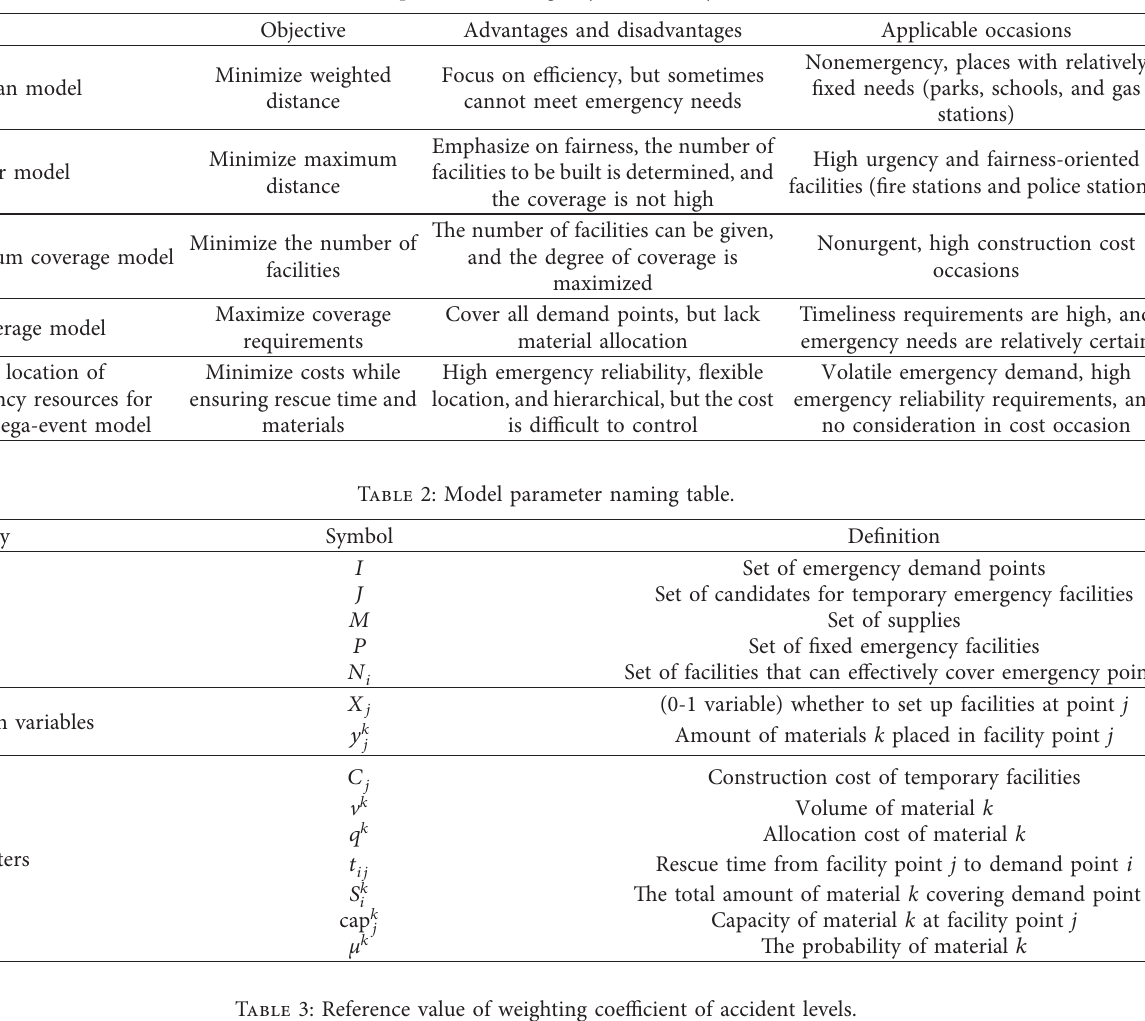
Table 1: Comparison of emergency resource layout